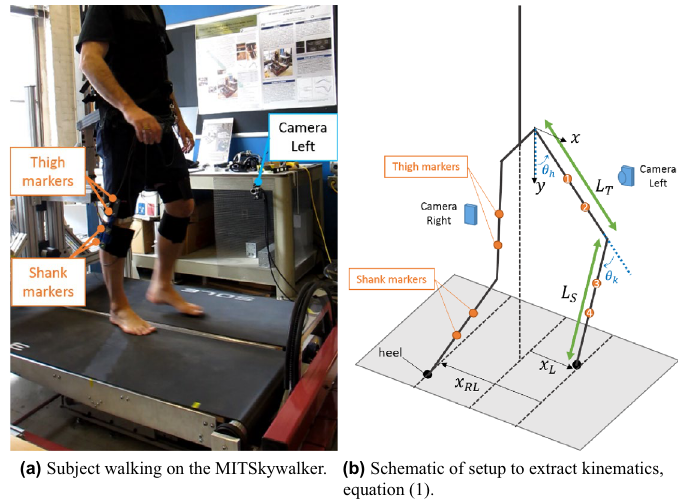
(a) Subject walking on the MITSkywalker. (b) Schematic of setup to extract kinematics, equation (1). Figure 8. Experimental setup for kinematic data acquisition in walking gait on the MIT-Skywalker 16